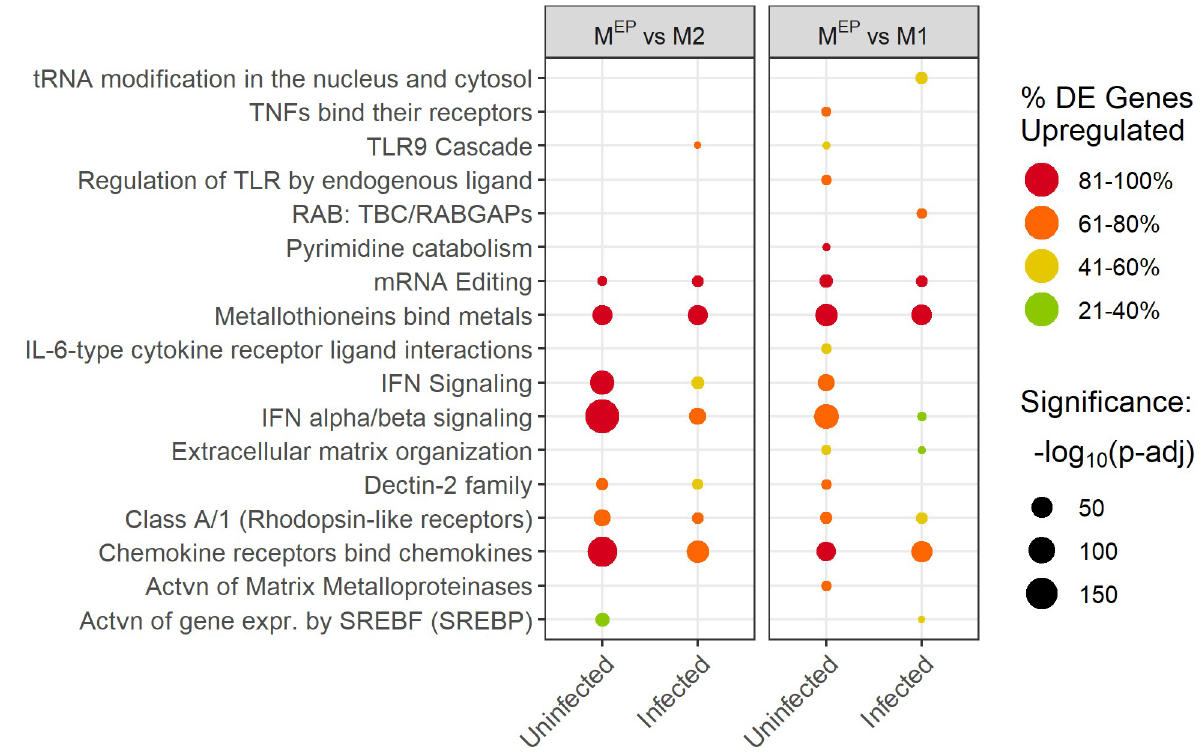
Fig 5. Pathways upregulated in in either uninfected or infected M EP when compared to M1 macrophages. The colour of the dots indicate the percentage of the differentially expressed genes found in the pathway which were upregulated: pathways that were largely upregulated are red, while pathways that were largely downregulated are green. The size of the dots indicates the significance level of the pathway enrichment, -log 10 (adjusted p-value), such that larger dots have smaller p-values. “p-adj” refers to the p-value adjusted using the Bonferroni correction for multiple testing. Only pathways for which the adjusted p-value was � 0.05 are